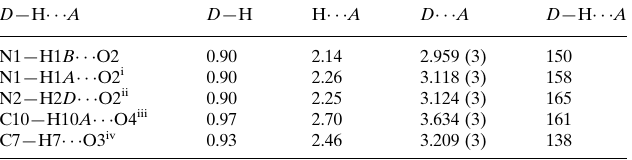
Hydrogen-bond geometry (A ˚ , (cid:2)